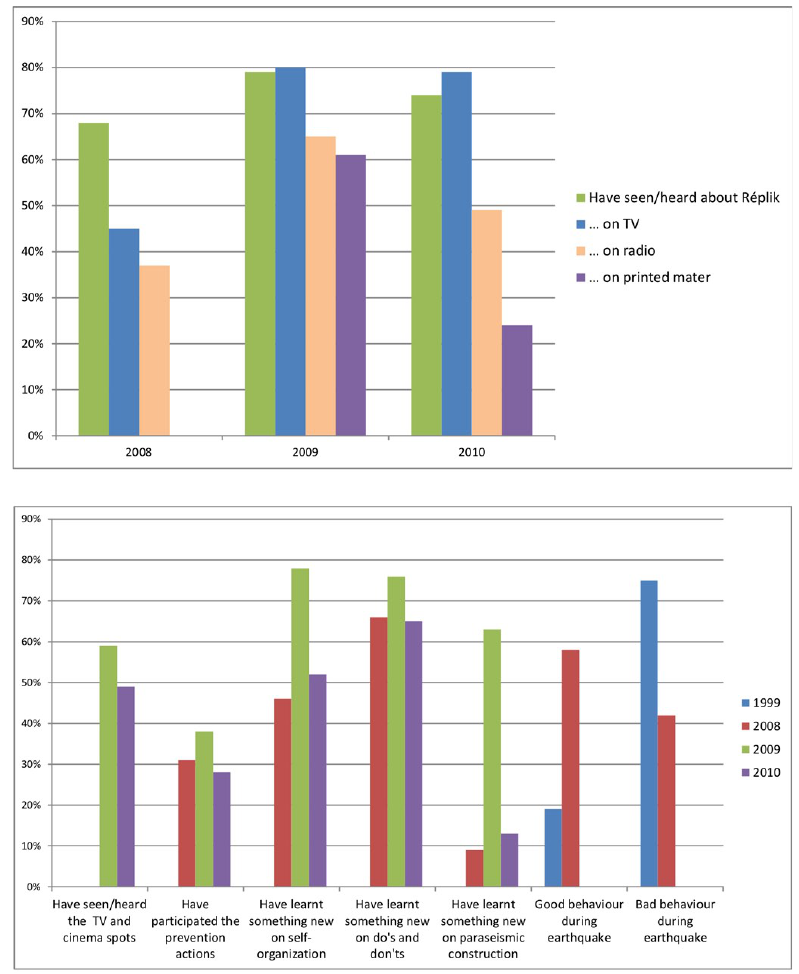
Fig. 4. Evolution of awareness and of several preparedness topics among successive polls within the Martinique population from 1999 to 2010. (A) Notoriety of R´eplik actions; (B) perception of prevention and preparedness